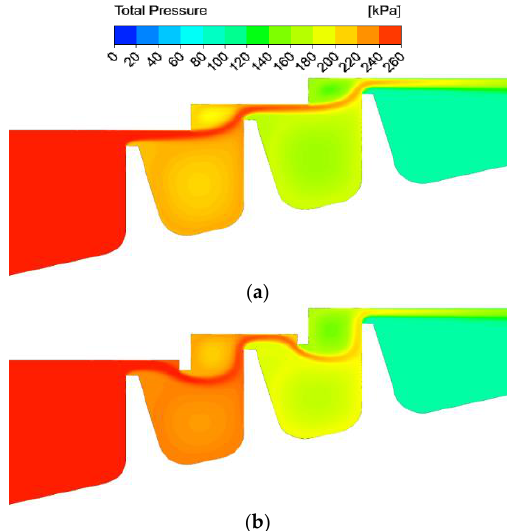
Figure 6. Total pressure plots for the conventional and ribbed seal (PR = 2.5, S/H = 0.6, t/K = 0.1, β = 90°). ( a ) Conventional seal. ( b ) Ribbed seal.